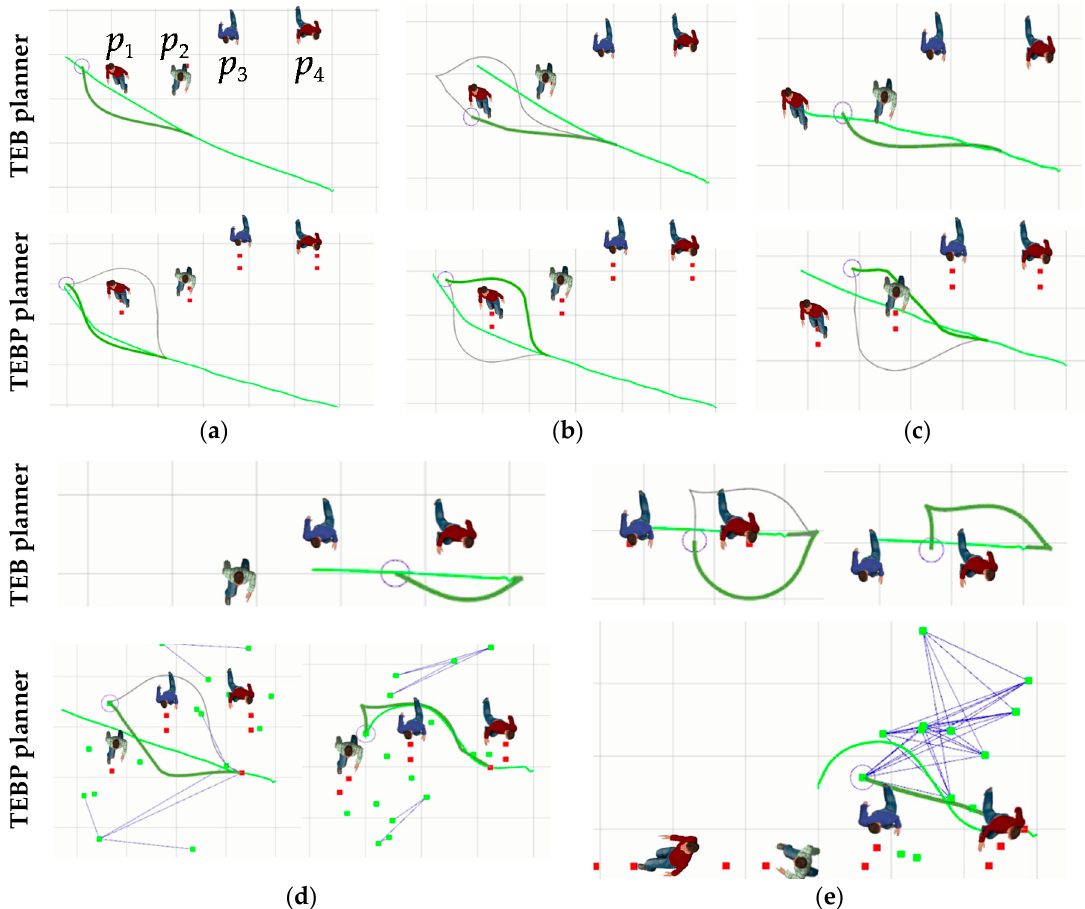
Figure 7. The trajectory planning process of avoiding four pedestrians with timed-elastic-band (TEB) and TEB with pedestrian trajectory prediction (TEBP) planners: ( a ) Initial state; ( b ) avoiding p 1 ; ( c ) avoiding p 2 ; ( d ) avoiding p 3 ; and ( e ) avoiding p 4 . The red dots represent the predicted pedestrians’ positions, and the green dots are sampling points to generate new trajectories. The circle in grey is the robot.